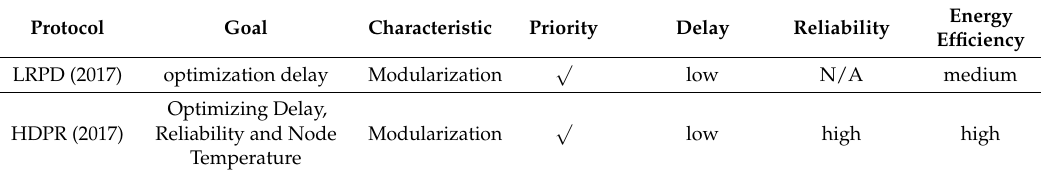
Table 6. Comparison of the Qos-based routing